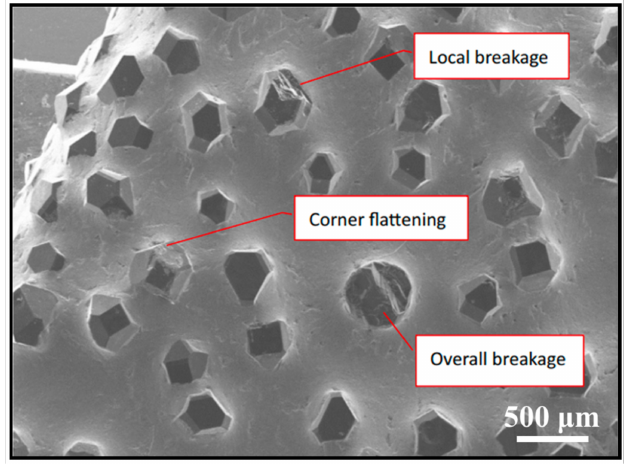
Figure 15. Whole morphology of diamond abrasive grains after grinding 10 times. Reprinted with permission from Ref. [70]. Copyright 2021, Elsevier.